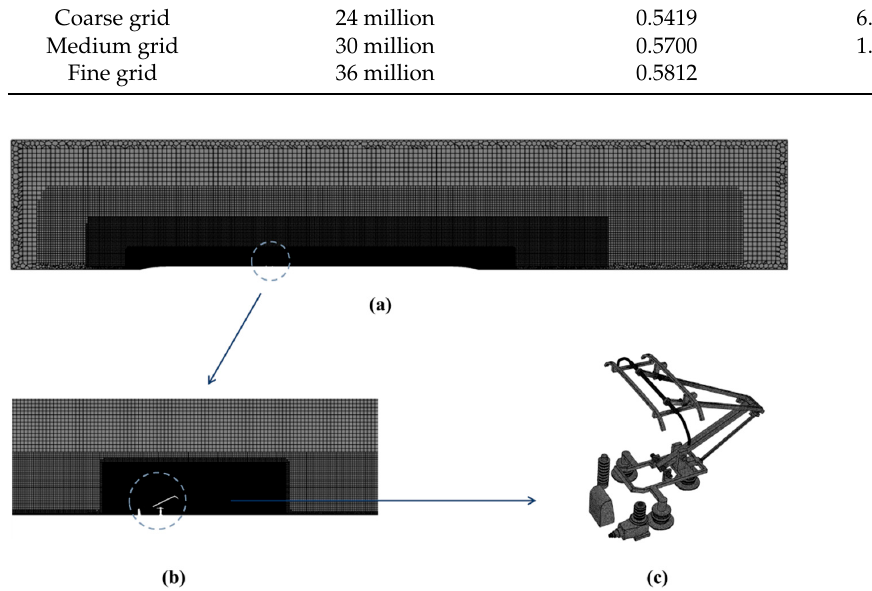
Figure 8. Sketch of the computational mesh. ( a ) Y-plane of the computational mesh; ( b ) enlarged view of the pantograph area; ( c ) enlarged view of the pantograph.